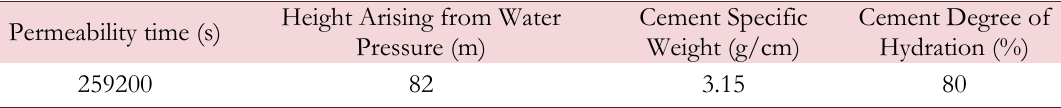
Table 5: Required values for calculating hydraulic conductivity coefficient and porosity of concrete.